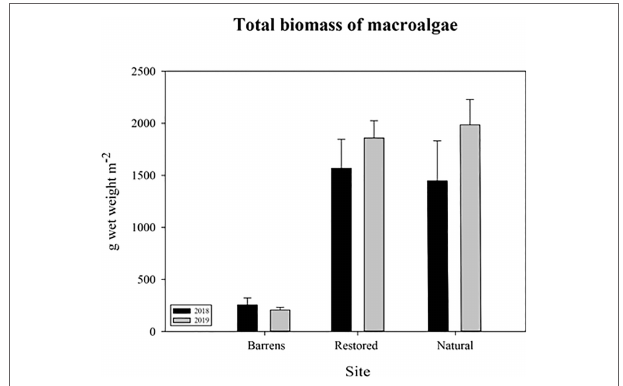
FIGURE 2 | Total biomass of macroalgae in barrens, restored bed, and natural bed in 2018 and 2019.